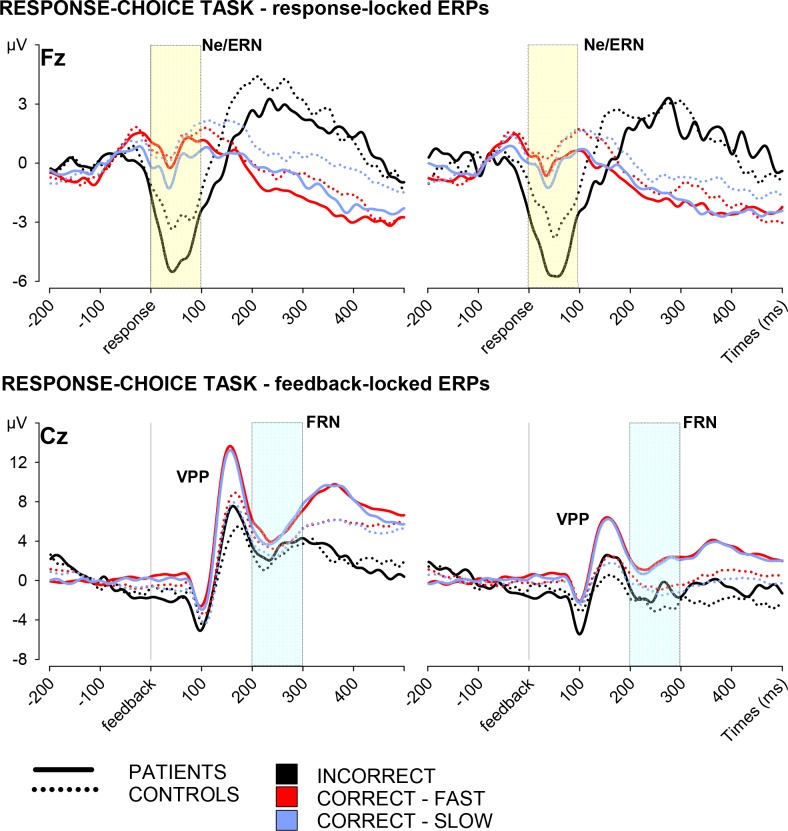
ERP results–response-choice task.Response-locked and feedback-locked grand average ERP waves for the processing of internal and external signals in the response-choice task. Colour areas highlight the time-windows considered for the calculation of the Ne/ERN (blue) and the FRN (pink).